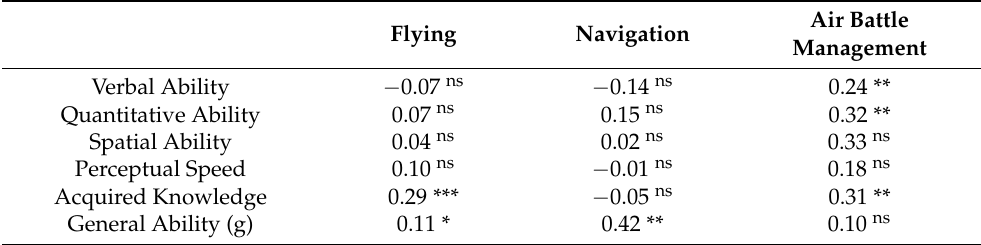
Table 5. Prediction of job performance by general ability and specific abilities via bifactor models.